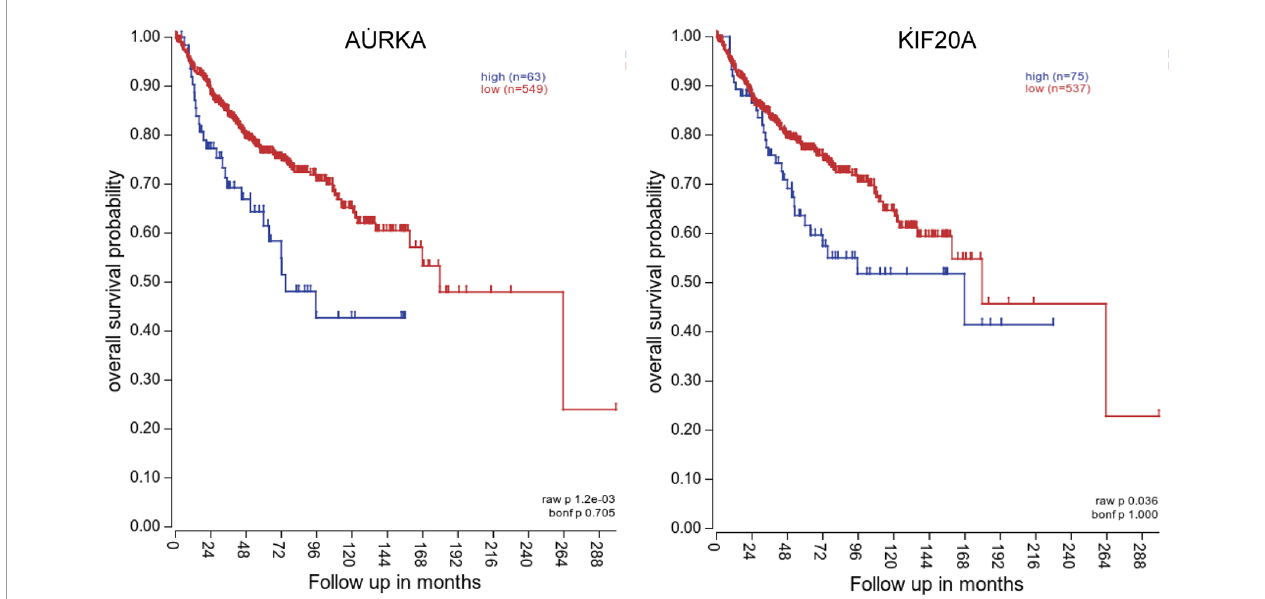
FIGURE 5 | Survival analysis of AURKA and KIF20A based on the GSE85217 database. (A) AURKA, (B) KIF20A. P < 0.05 was considered statistically signi fi cant.